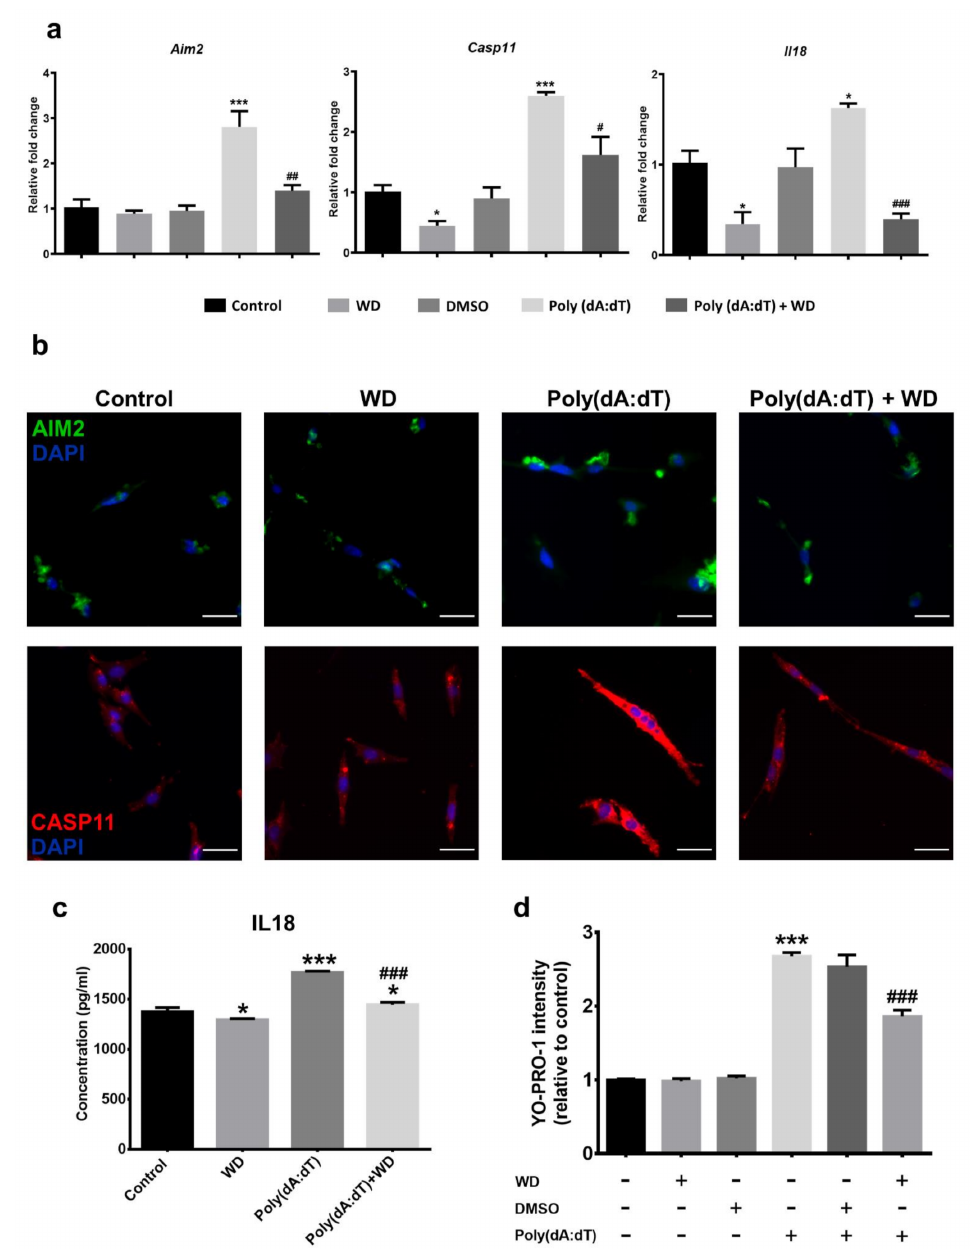
Figure 4. 661W photoreceptor cells were incubated with Poly(dA:dT) (5 µ g/ml) ± WD (50 µ M) or DMSO (0.01%) for 8 h prior to analysis. ( a ) Relative mRNA expression of inflammasome components in 661W photoreceptor cells, compared to the reference gene Actb. n = 3 per group; n represents the average of three experimental repeats. ( b ) Representative immunocytochemistry images of AIM2 (green) and CASP11 (red) taken from treated 661W photoreceptor cells, counterstained with DAPI (blue) to visualise the nucleus. Scale bar: 50 µ m. ( c ) The relative protein expression and release of inflammatory cytokine IL18 was quantified through ELISA. The results were calculated by interpolating the absorbance values against a standard curve of known IL18 concentrations. n = 3 per group; n represents the average of three experimental repeats. ( d ) Cell viability of 661W photoreceptor cells was determined by YO-PRO-1 uptake after 8 h of treatment; n = 6 per group. One-way ANOVA with Tukey’s post-hoc test. * p < 0.05 and *** p < 0.001: relative to the control. # p < 0.05, ## p < 0.01, ### p < 0.001: relative to Poly(dA:dT). Error bars shown as mean ±